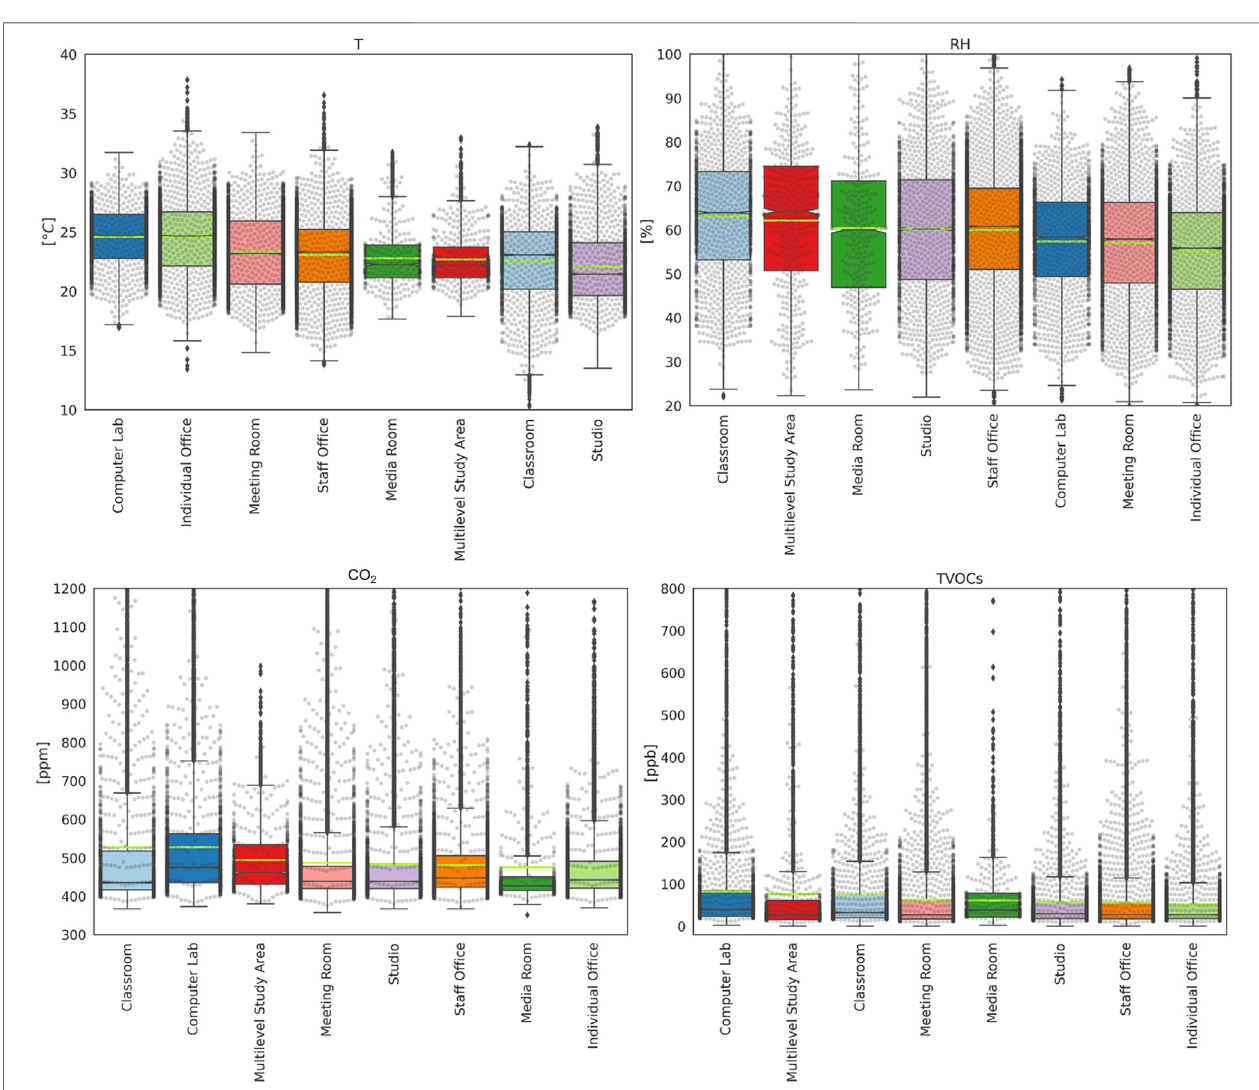
FIGURE4| DifferentIEQ behaviouracrossdifferentroom types understandardoccupancy (Term1). The y -axislimits areadjustedfor abetter visualcomparison of results. The swarmplots show daily mean observations and complement the representation of the underlying hourly distribution (boxplots).